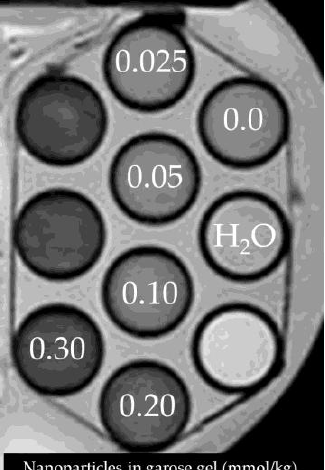
Zn Gd Fe O 0.5 0.5 0.02 1.98